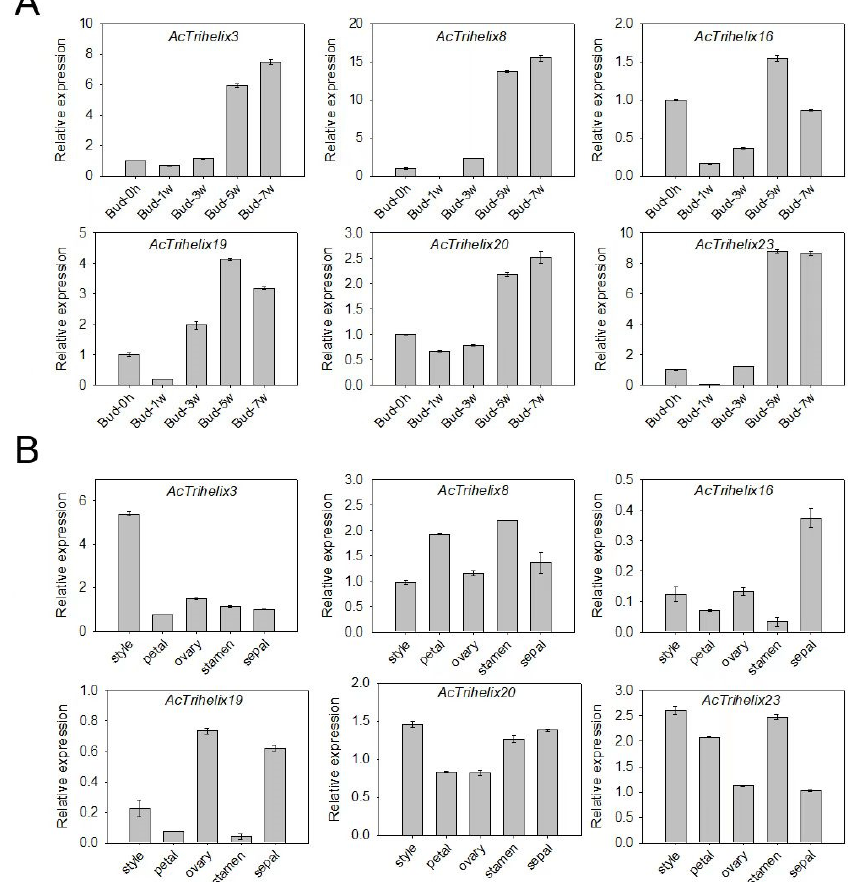
Figure 9. qRT ‐ PCR validation of six AcTrihelix genes involved in flowering regulation: ( A ) relative expression levels of AcTrihelix genes in flower induction and flowering process. The labels Bud ‐ 0h, Bud ‐ 1w, Bud ‐ 5w, and Bud ‐ 7w on the X ‐ axis represent the time (0 h, 1 week, 3 weeks, 5 weeks, and 7 weeks) after ethephon treatment. The Y ‐ axis indicates the relative expression level of each gene; ( B ) the expression level of AcTrihelix genes in different floral organs. The values are presented as the mean ± SE (n = 3).